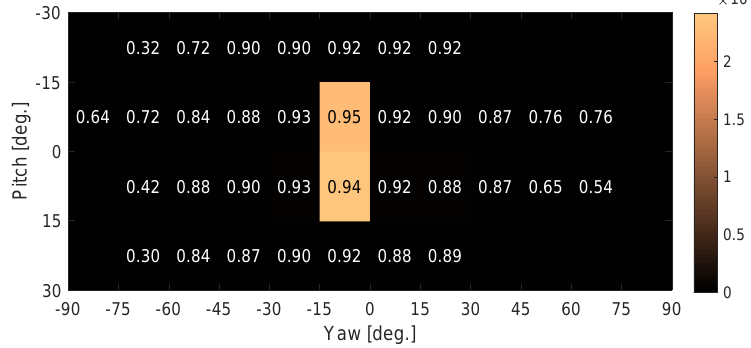
Figure 11. Head pose success classification rate for 5 degrees tolerance.